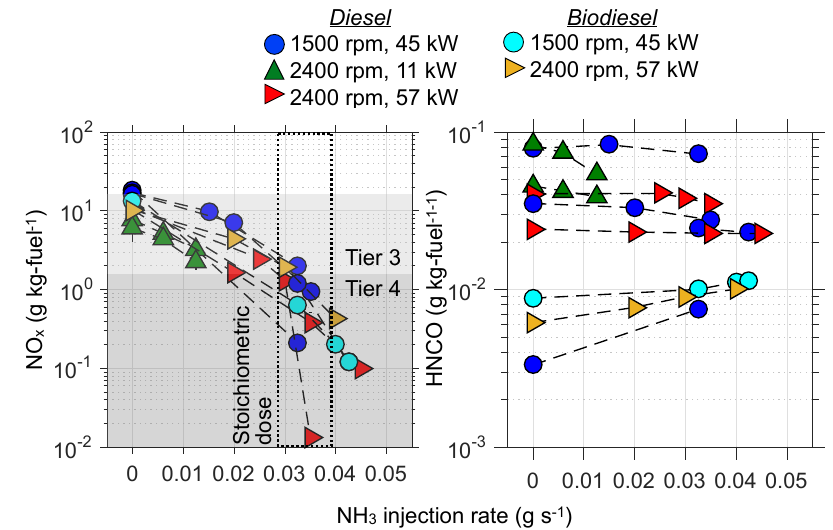
Figure 2. Emission factors for (a) NO x (NO + NO 2 ) and (b) HNCO with varying NH 3 injection rates for all the experiments performed in this work. The NH 3 injection rates are calculated assuming each urea molecule produces two NH 3 molecules.